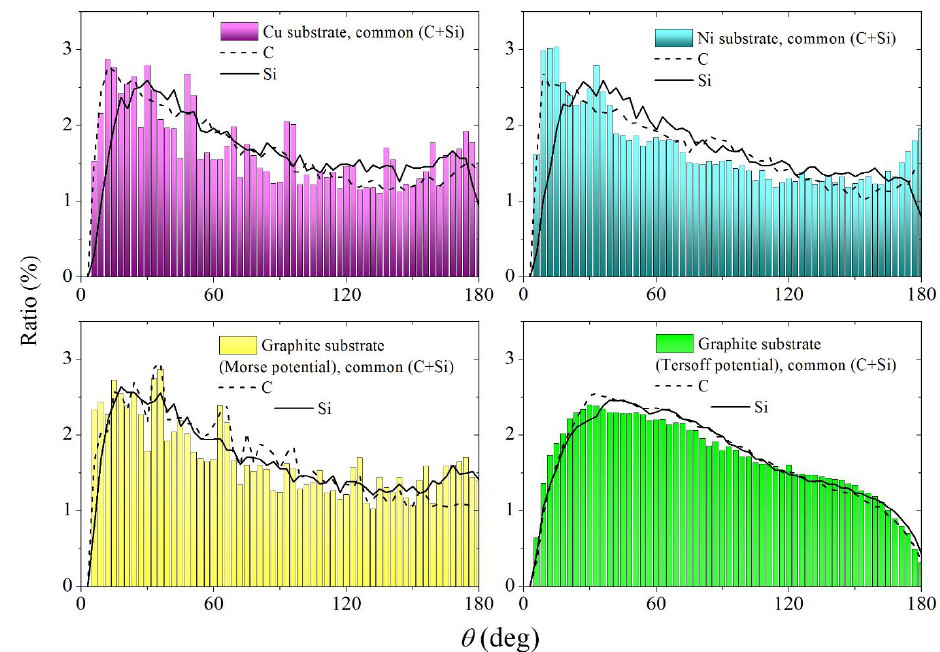
Figure 9. Angular distributions of the nearest geometric neighbors obtained at the final stage of deposition of the SiC film on various substrates, both for the entire SiC film and for its individual components (C and Si); the interaction between Si or C atoms and a graphite substrate is carried out using Morse and Tersoff potentials.